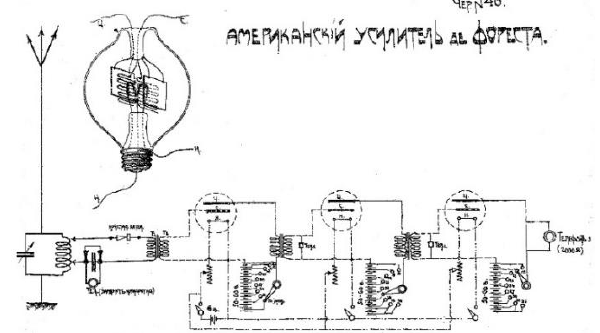
Fig. 11. Schematic diagram of a detector radio with a three-stage sound frequency amplifier designed by Lee de Forest, which was delivered to Russia.